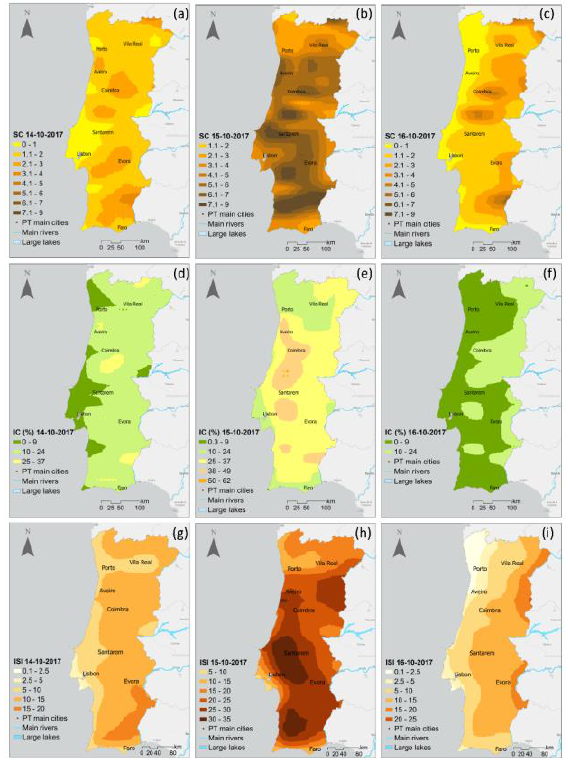
Figure A6. Daily mean values for ( a , d , g ) 14, ( b , e , h ) 15, and ( c , f , i ) 16 October 2017, for SC (upper row), IC (middle row), and ISI (lower row).